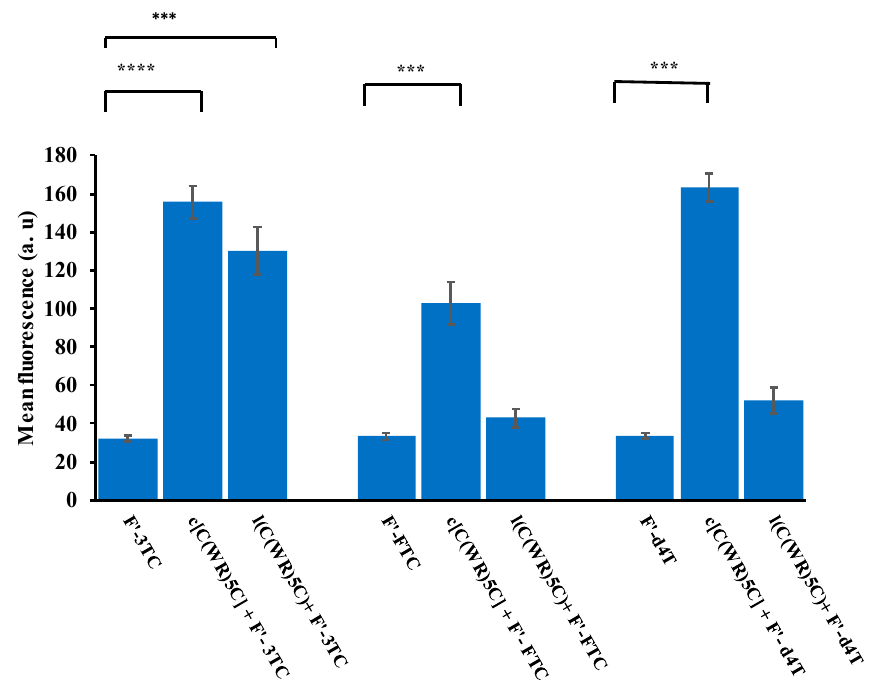
Figure 9. FACS analysis of the uptake of F ′ -d4T, F ′ -3TC, F ′ -FTC, and F’-d4T (5 µM) using synthesized peptides l(C(WR) 5 C) and c[C(WR) 5 C] at 25 µM in MDA-MB-231 cells after 3 h incubation ( n = 3, if p < 0.05 then *, if p < 0.01 then **, if p < 0.001 then ***, if p < 0.0001 then ****). Error bars are SD. Molecules 2020 , 25 , x